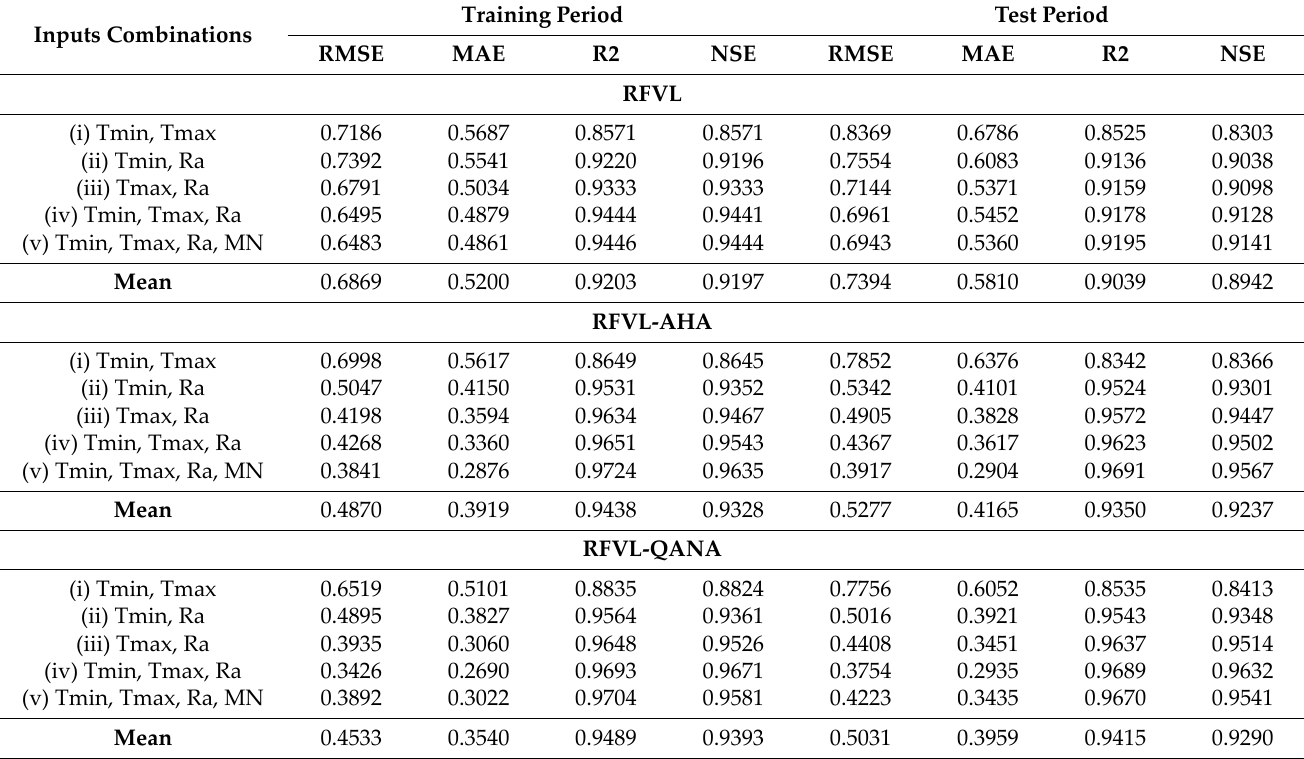
Table 5. The results of the RFVL‑based models for Peshawar Station using the best training‑test partition (75–25% scenario).